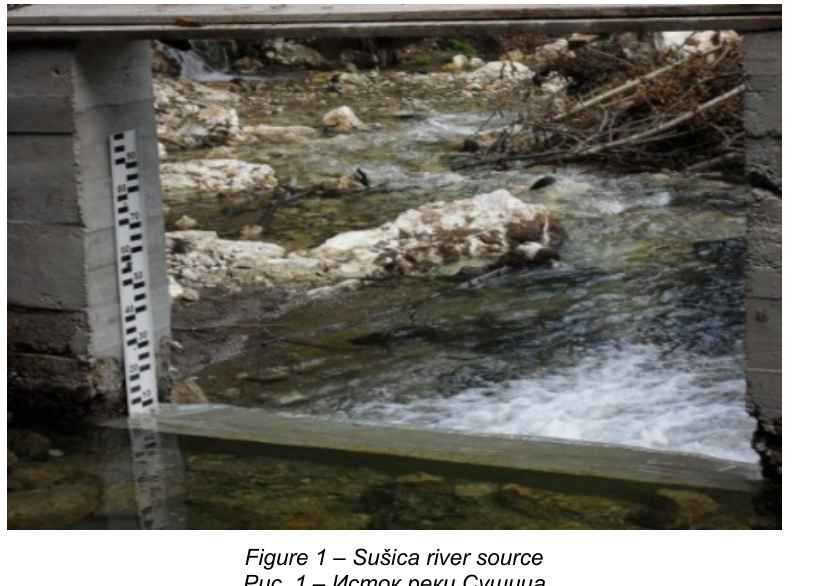
Figure 1 – Sušica river source Рис . 1 – Исток реки Сушица Слика 1 – Извориште реке